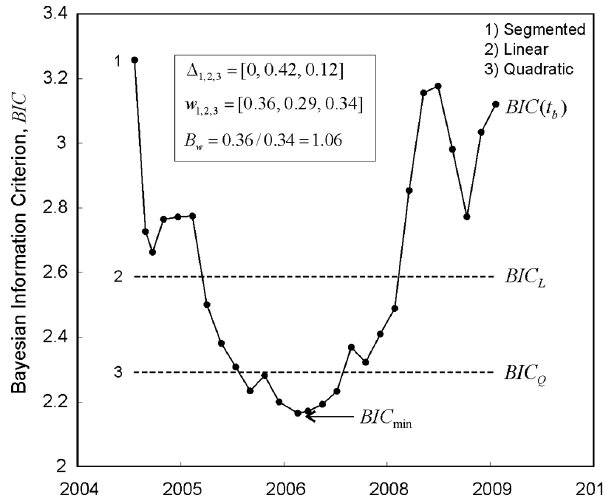
Fig. 3. Sample application of the segmented regression model to the time series shown in Fig. 1d. BIC (t b ) indicates the goodness of fit of the segmented model (lower values indicate better fit), computed by Eq. (1) as a function of the breakpoint position t b . BIC L and BIC Q indicate the linear and quadratic fit computed for the entire time series. The inset shows the “evidence ratio” of the breakpoint computed by Eqs. (4) and